Question: Sum up the contents of this chart in one sentence.
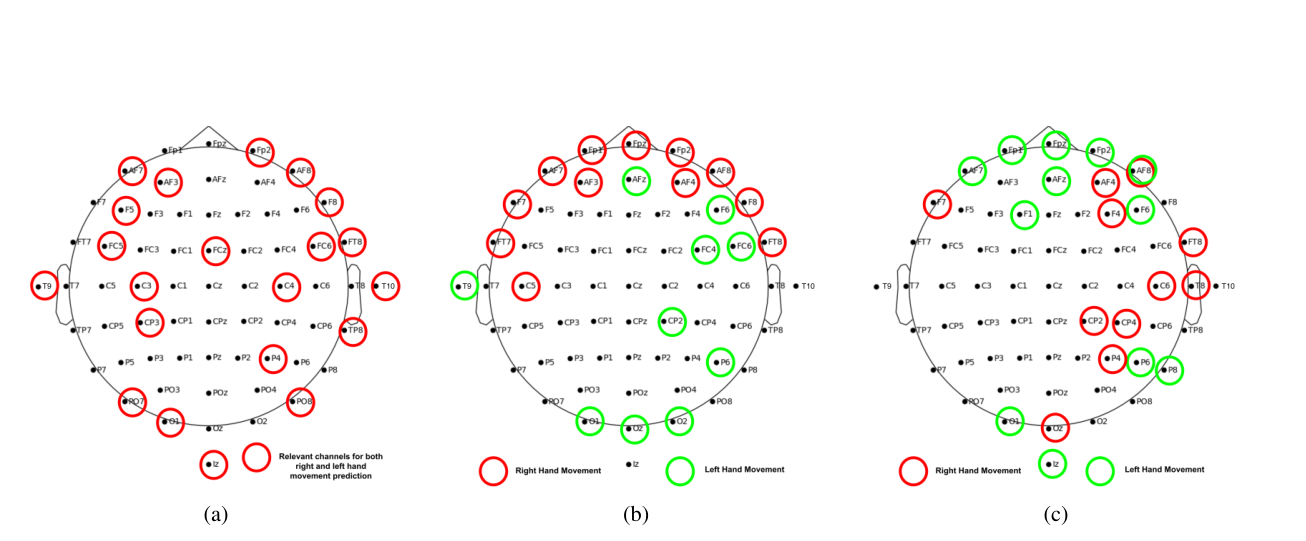
Answer: Montage images highlighting the significant channels among the 64 channels, identified by a) using feature relevance scores based on Riemannian distance on covariance matrix, b) using GradCAM with EEGConformer model, and c) using GradCAM with EEGNet model.